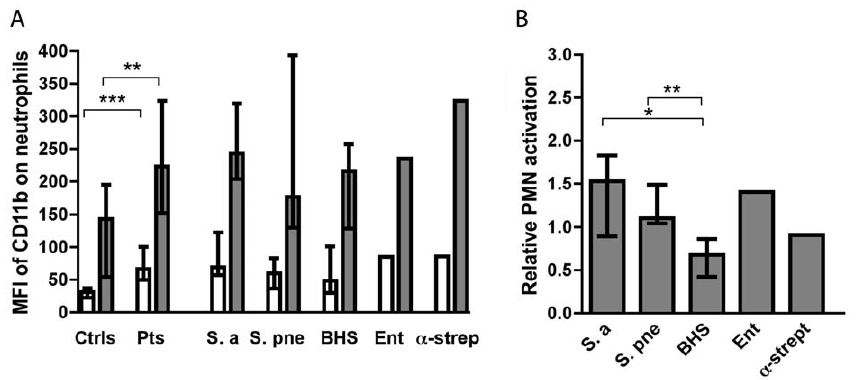
Figure 3. Neutrophil activation in healthy controls and in patients. (A) Neutrophil activation in healthy controls, in all of the patients, and in patients grouped by their respective infective organism. Neutrophil activation is given as the MFI of CD11b in response to buffer only (open bars) or ADP/fMLP (grey bars). Values are 6 interquartile range. In (B) the increase in MFI of CD11b by different bacteria relative to the increase caused by stimulation of ADP is shown. * P , 0.05, ** P , 0.01, *** P , 0.001 after Mann-Whitney U testing.